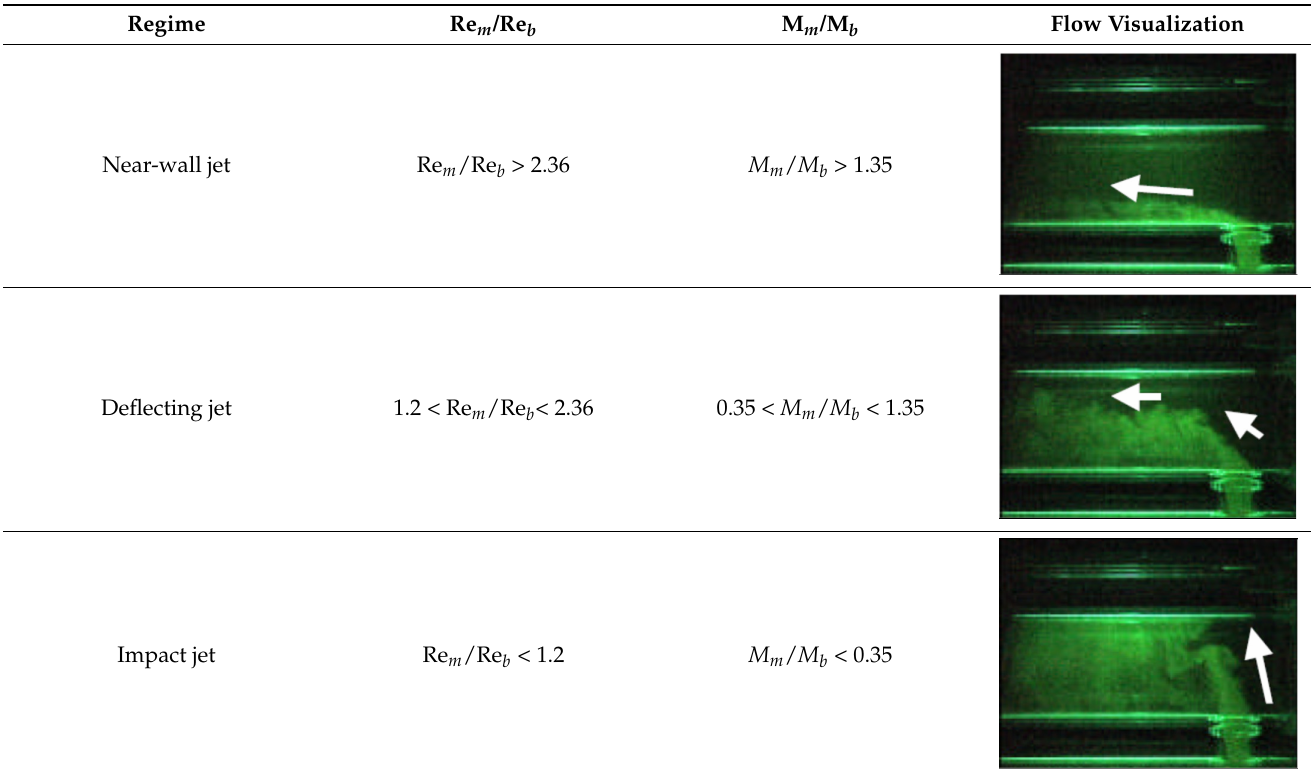
Table 1. T-junction flow regimes [9,10].